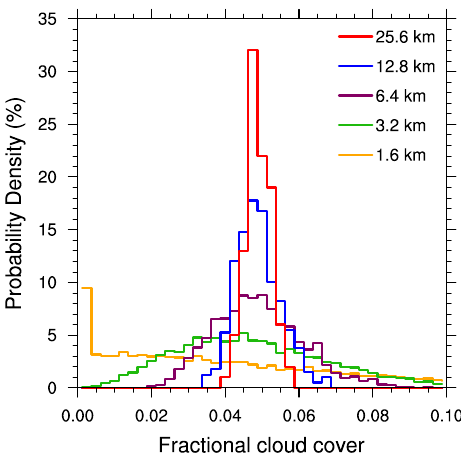
Figure 6. Schematic representation of the stochastic PC-2008 ap-